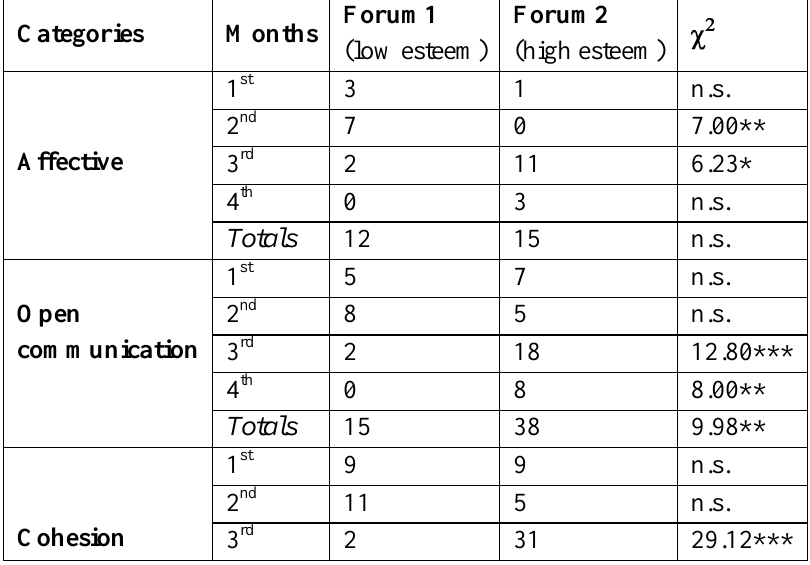
Social Presence: Students’ Postings Only